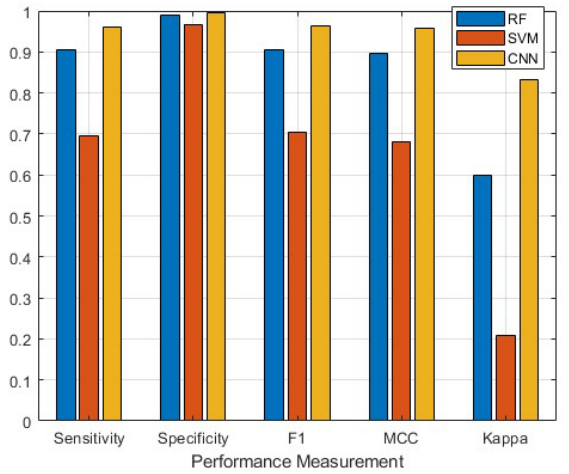
Figure 6. A comparison of the overall performance metrics for each approach: random forest (RF), support vector machine (SVM) and convolutional neural network (CNN) . MCC is the Matthew’s Correlation Coefficient.